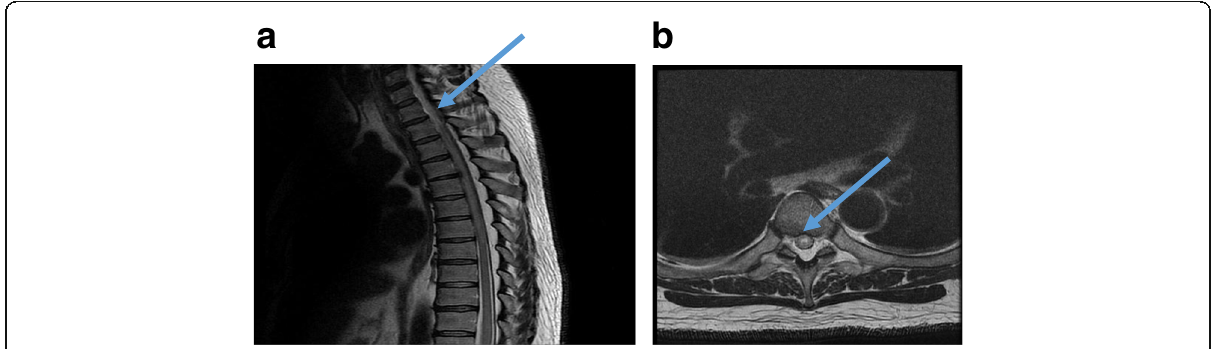
Fig. 1 a Sagittal T2-weighted magnetic resonance imaging (MRI) scan through the thoracic spinal cord obtained on postoperative day 2 showing abnormal T2 high signal intensity from the Th3 to Th8 levels (arrow). b Axial T2-weighted image showing high signal intensity in the anterior horn of the gray matter (owl ’ s eye) at the Th5 level